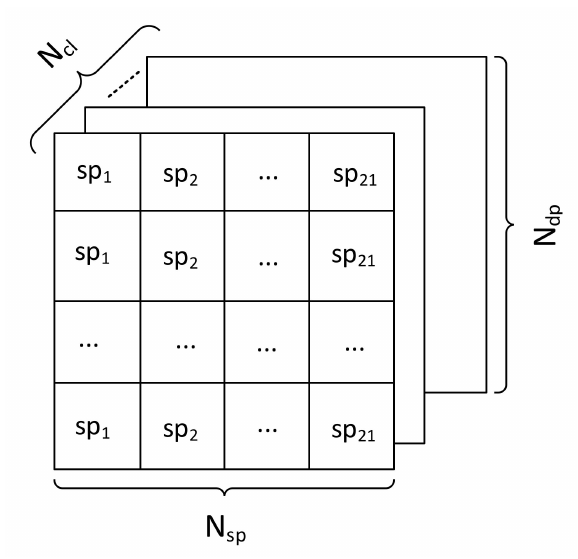
Figure 3. The illustration of data point